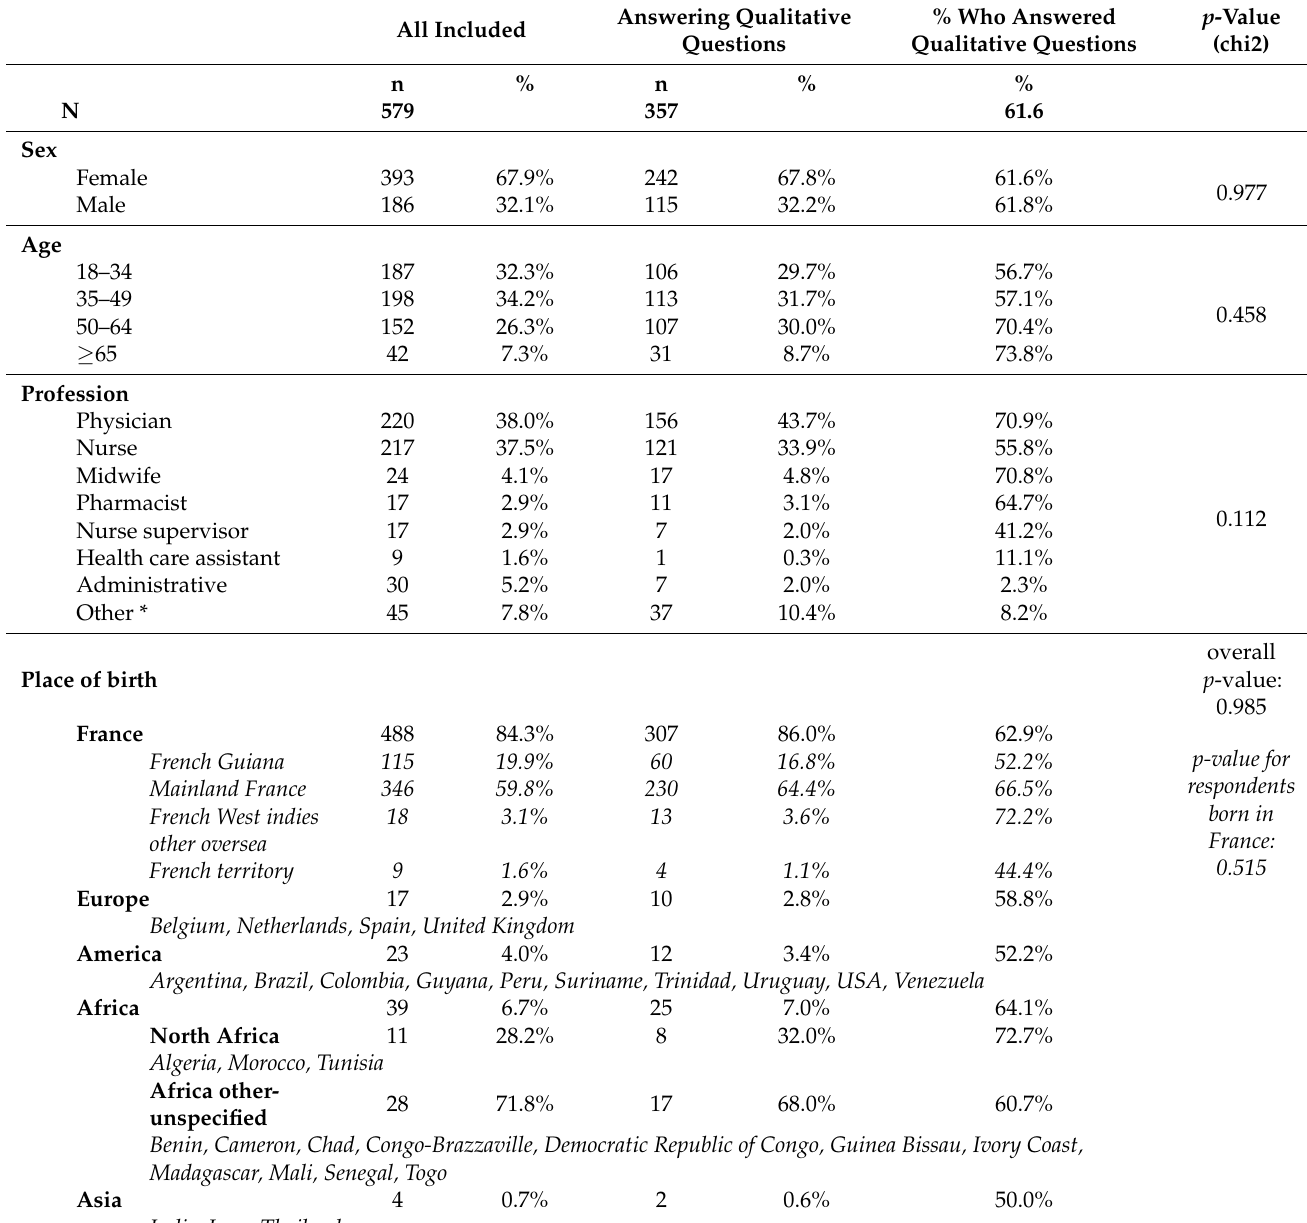
Table 1. Description of the study population, health care workers in French Guiana, January–March 2021. All